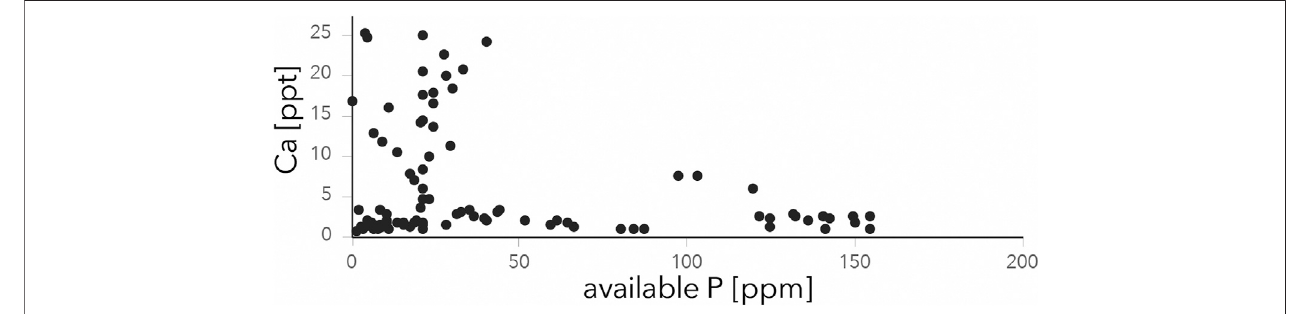
FIGURE8| RelationshipbetweensoilCaandplantavailablePinthestudyregion.Notethe ∼ 10 pptthresholdofCaconcentrationssupressingavailablePintopsoil samples.